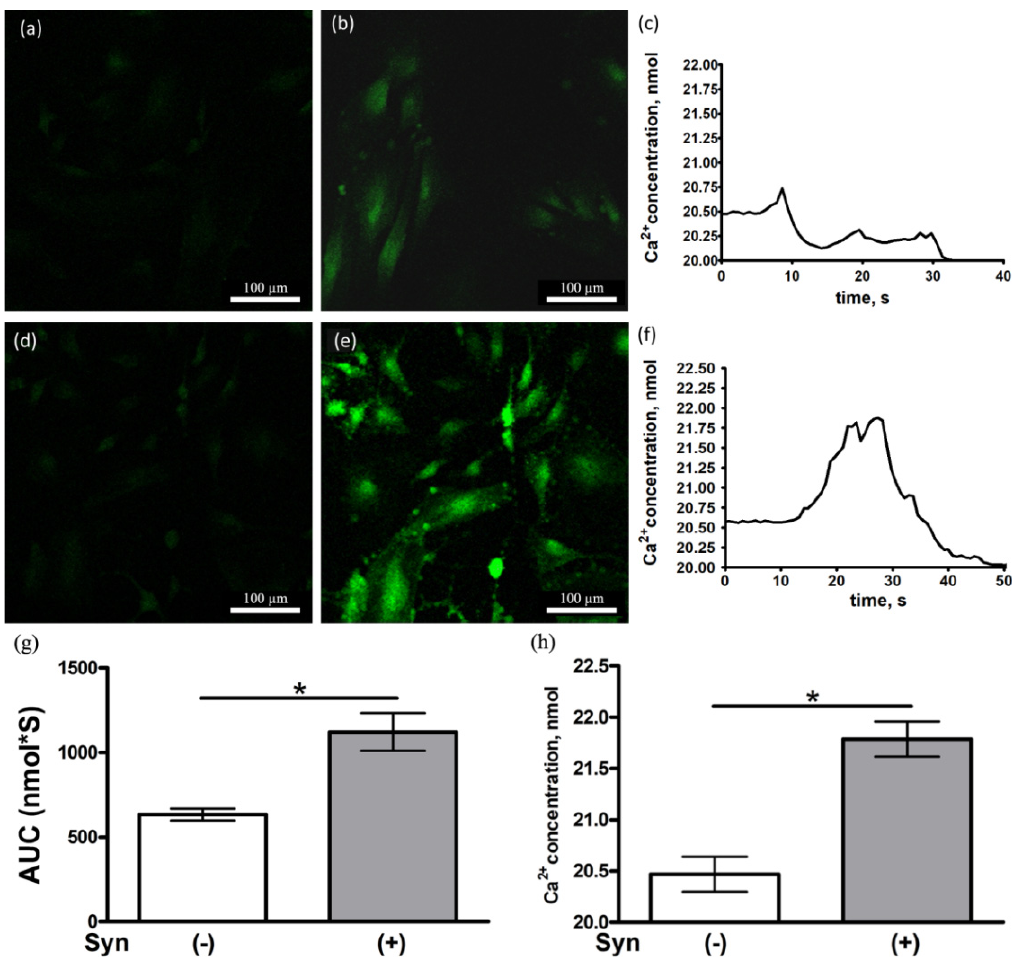
Figure 6. Ca 2+ level in astrocytes under the influence of aspartate. Change in fluorescence of cells stained with Fluo-4 AM in the group Syn (–) ( a ) 0.8 s, ( b ) 9 s; and Syn (+) ( d ) 0.8 s, ( e ) 28 s. Dynamic ranges of Ca 2+ concentration increasing in astrocytes in group ( c ) Syn ( − ) and ( f ) Syn (+). ( g ) AUC (area under the curve) concentration of Ca 2+ in astrocytes. ( h ) Ca 2+ concentration at the highest fluorescence peak point. Data are presented as mean ± SEM, n = 9/number of analyzed samples, * p < 0.05 (Mann–Whitney